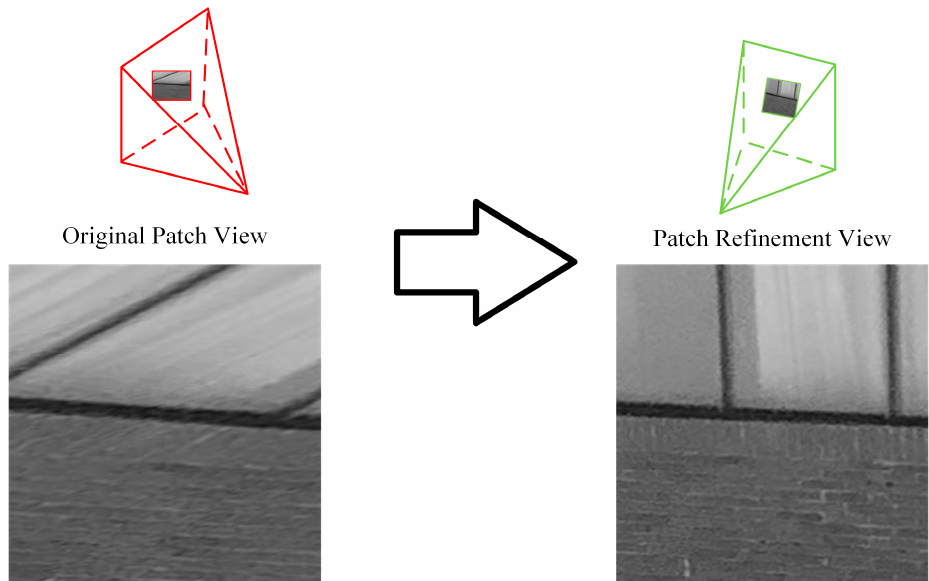
Figure 10. Rectified effect of the refined patch. The red view frustums are original camera poses. Green view frustums are the patch refinement view.